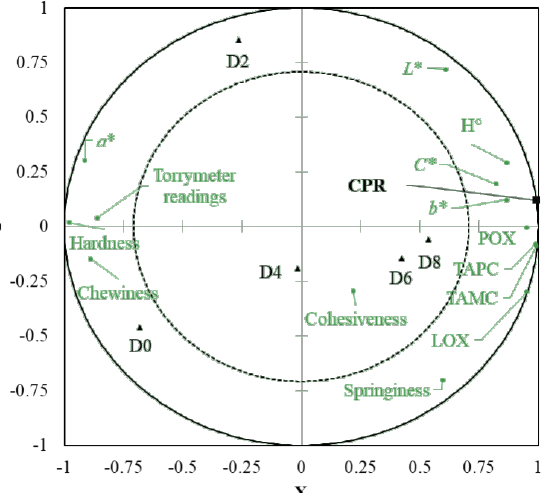
Figure 2. Partial least square regression (PLSR) model for the freshness parameters of Nile tilapia ( Oreochromis niloticus ) fillets stored at 4 ± 1 ◦ C for 8 days. X axis = freshness parameters; Y axis = consumer’s purchase rejection (CPR). LOX—lipid oxidation; POX—protein oxidation; C *—chroma; H ◦ —hue angle; TAMC—Total aerobic mesophilic count; TAPC—total aerobic psychrotrophic count.